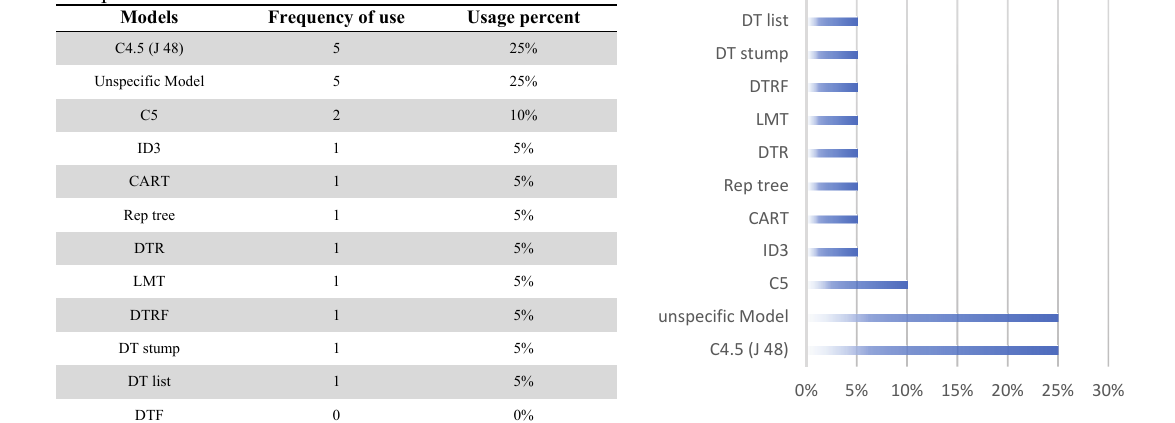
Fig. 9. Comparison of the Decision Tree models